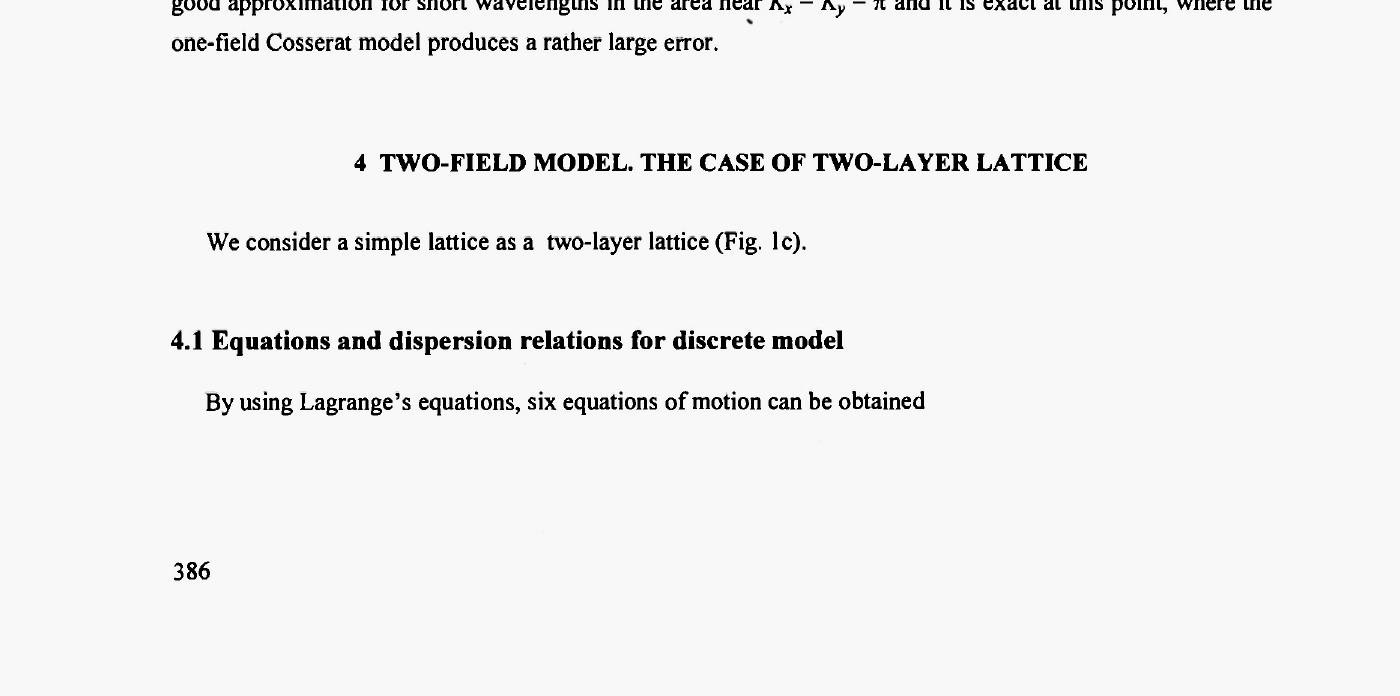
Fig. 2 a,b: Dispersion curves of shear, compression, micro-rotational waves for the lattice (solid line), Cosserat continuum model (dotted line), two-field models (dash